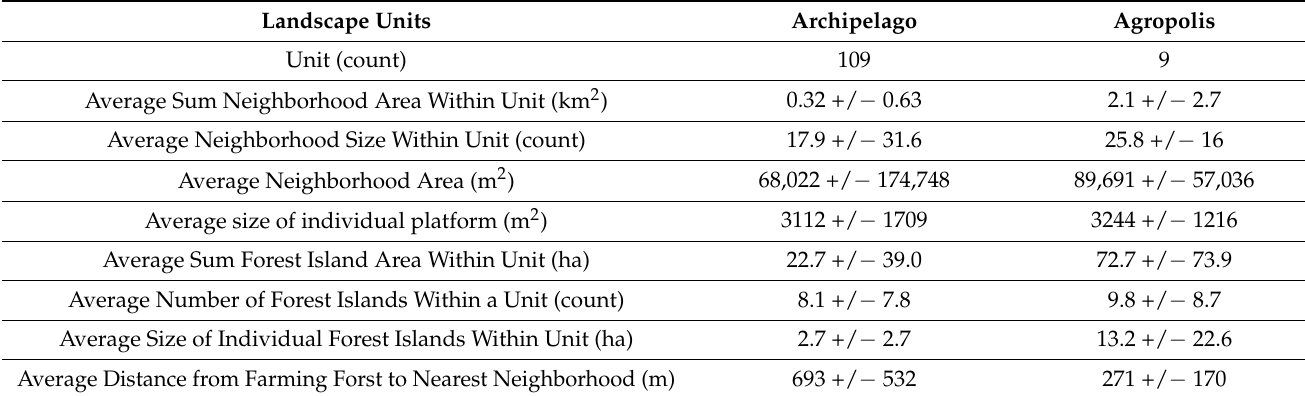
Table 5. Descriptive statistics comparing archipelago and agropolis landscapes, and the forest islands and raised fields that comprise